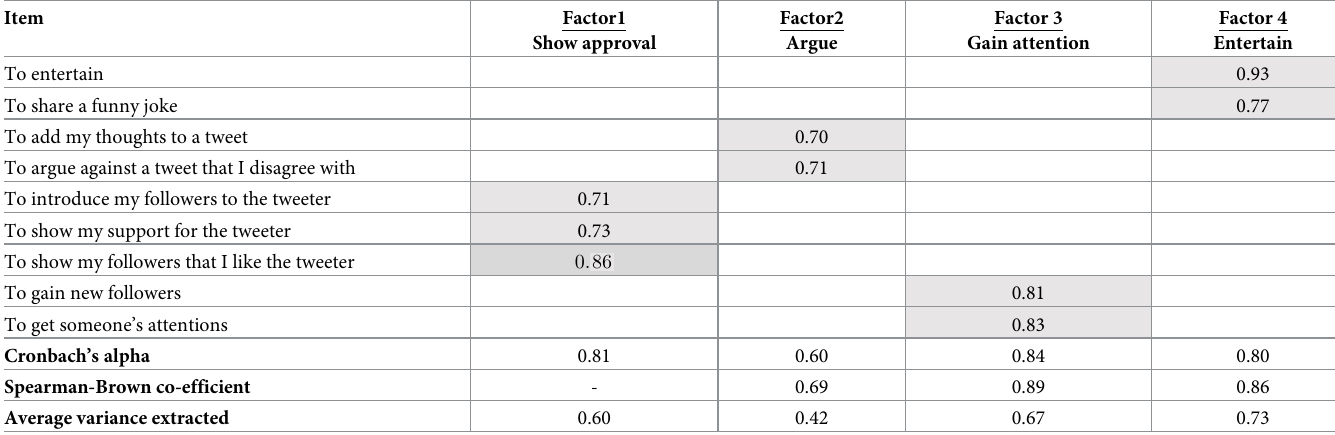
Table 3. Confirmatory factor analyses item loadings, and Cronbach coefficient alpha for 4 factors. (NValidation =